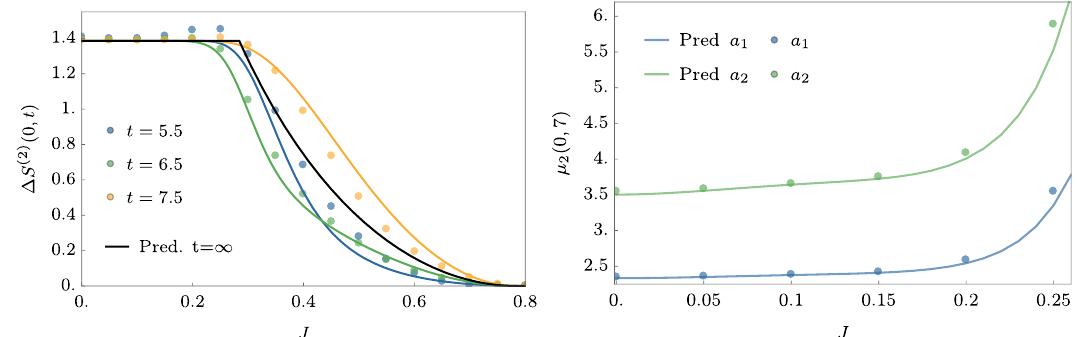
Figure 4: The slope ∆ S ( 2 ) ( y , t − 1 / 2 ) = S ( 2 ) ( y , t ) − S ( 2 ) ( y , t − 1 ) and the constant ( y , t ) (much more sensitive) versus the parameter J for a dual unitary offset factor µ 2 gate with r = 0.5, φ = 0.7, θ = 0 (see Appendix C for the definition of the gate). = σ = α σ + α σ + α σ We show the results for operators a (left panel) and a 1 3 2 1 1 2 2 3 3 = 0.3289, α = 0.0696, α = 0.6221. The points a fixed random operator with α 1 2 3 correspond to exact numerical results, and the lines are the predictions using the conjecture (83). The operator is initialised at y = 0, and we set t = 7 for the right panel.